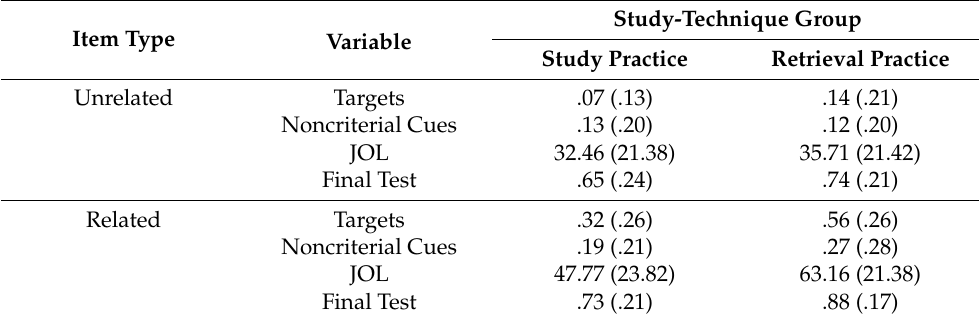
Table 6. Mean cue accessibility, JOL, and final-test